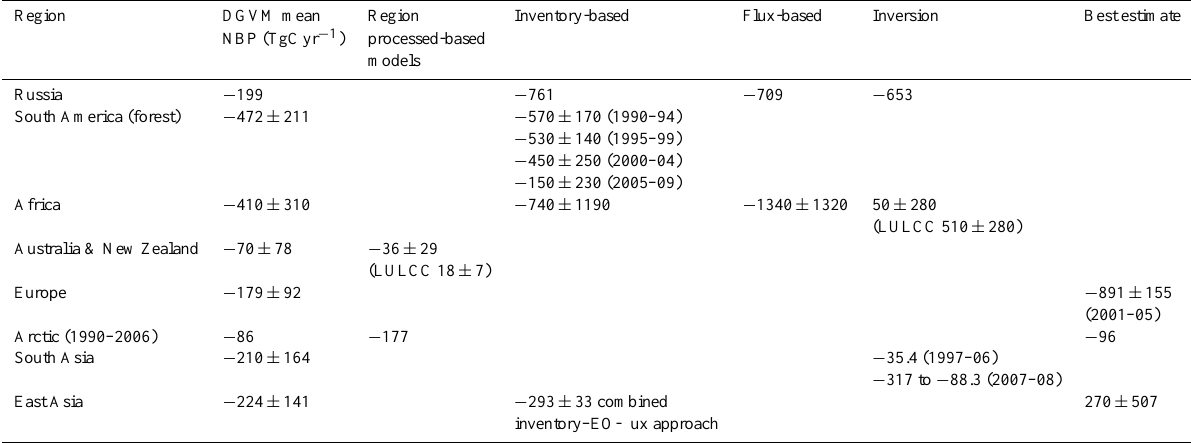
Table 4. Ensemble DGVM regional NBP mean comparison with RECCAP regional chapter analyses.